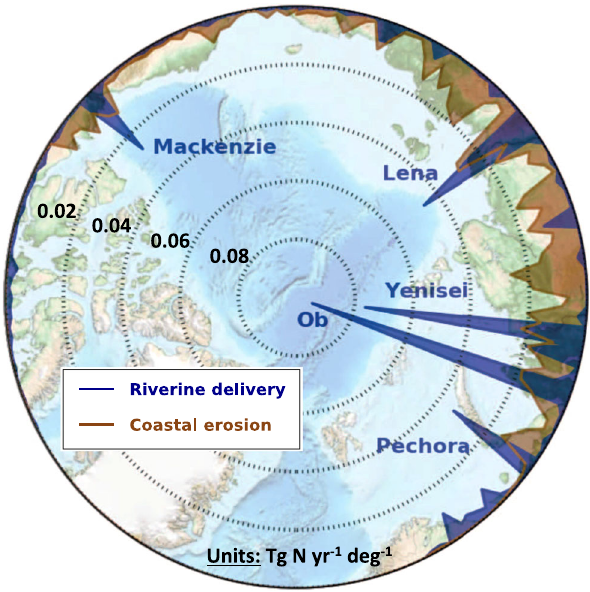
Fig. 1 Map of annual input of terrigenous nitrogen via rivers and coastal erosion. Input fl uxes are aggregated per degree longitude.